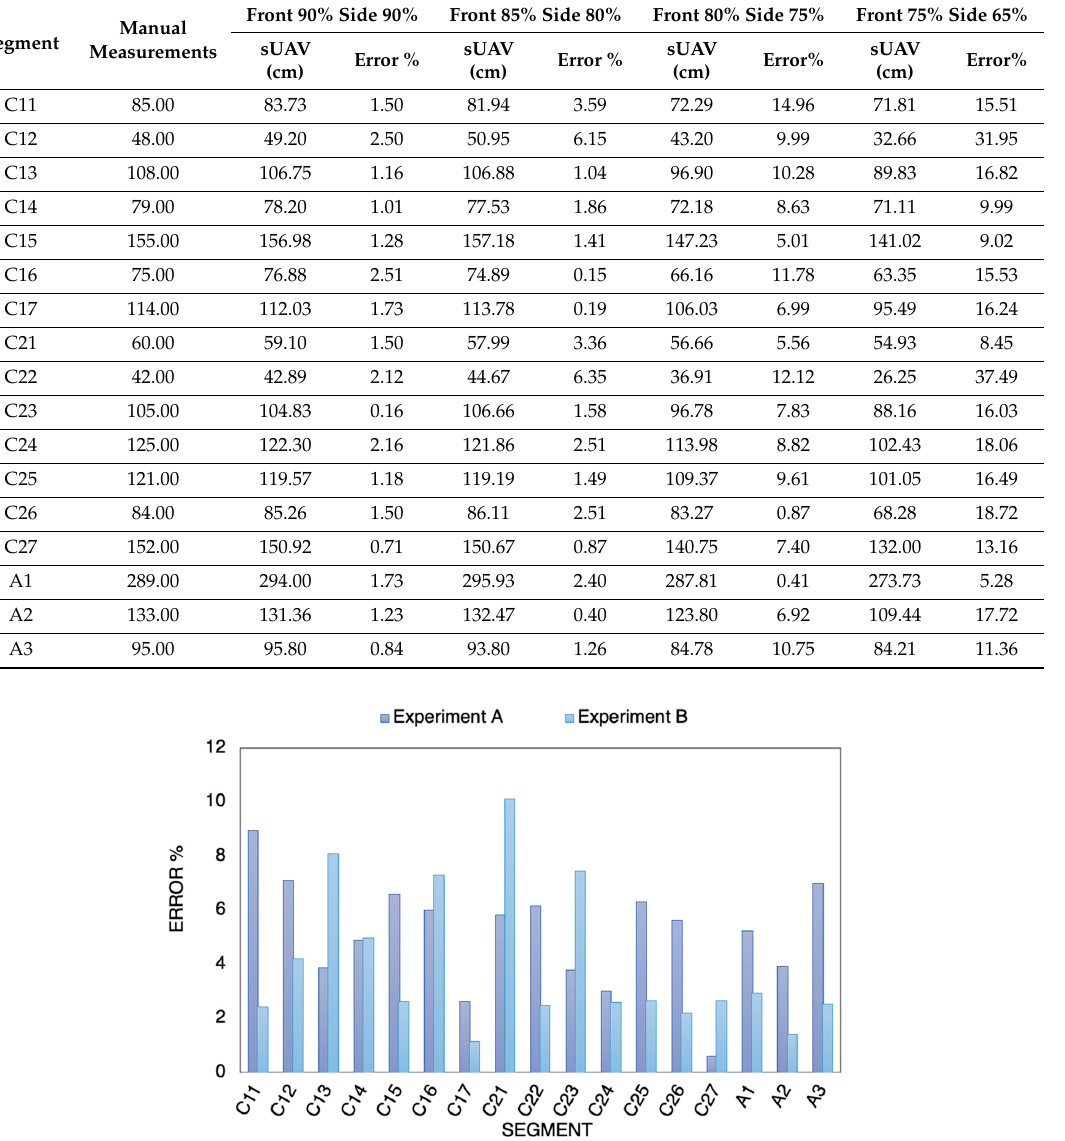
Figure 6. Error percentage between manual measurements and sUAV measured segments of Experiments A and B.